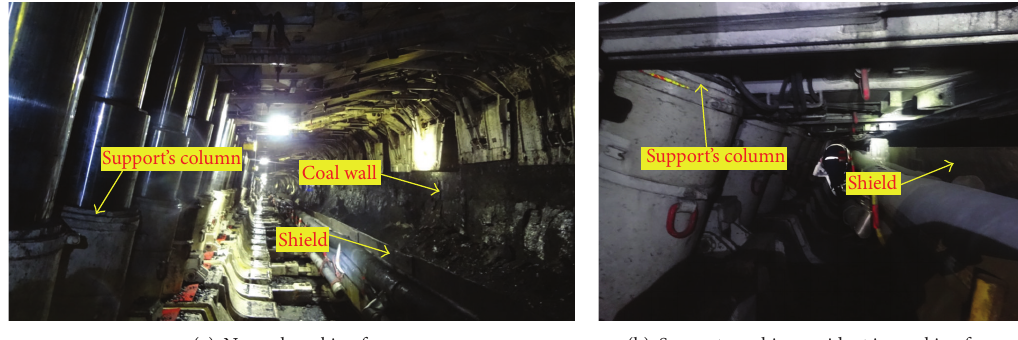
Figure 2: Comparison diagram in working